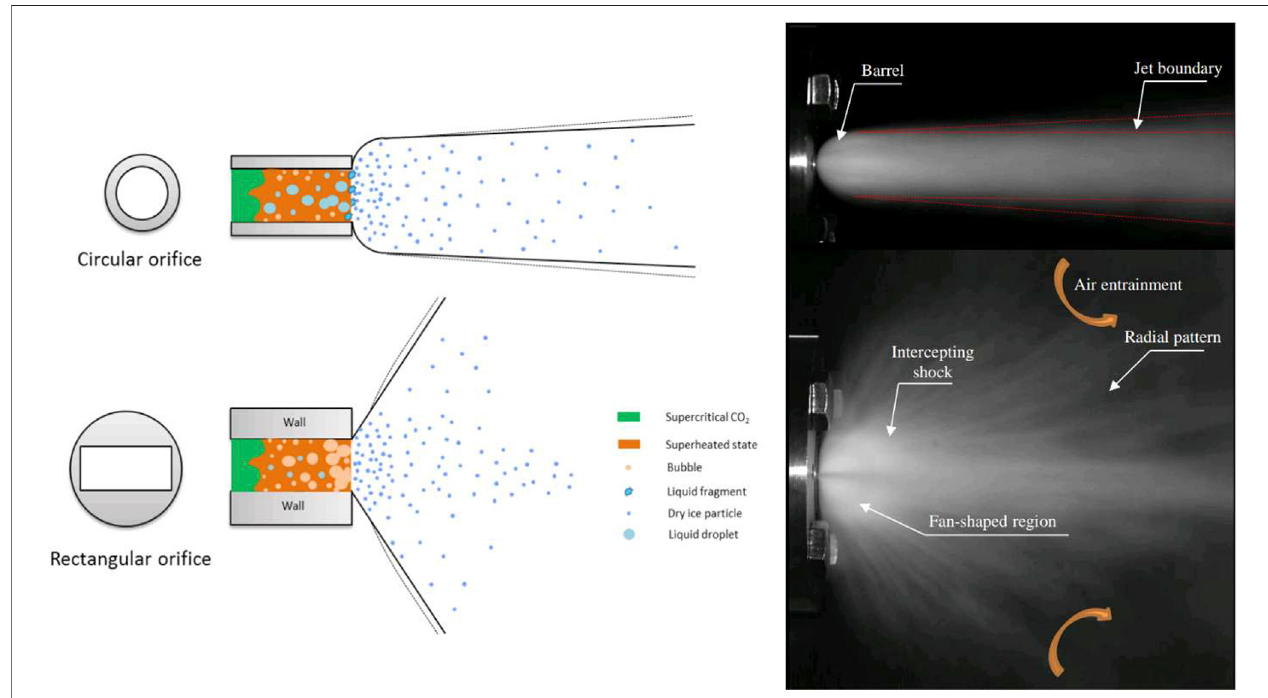
FIGURE 1 | The schematic of the non-condensing gas turbulent jet (Dong, 2005).